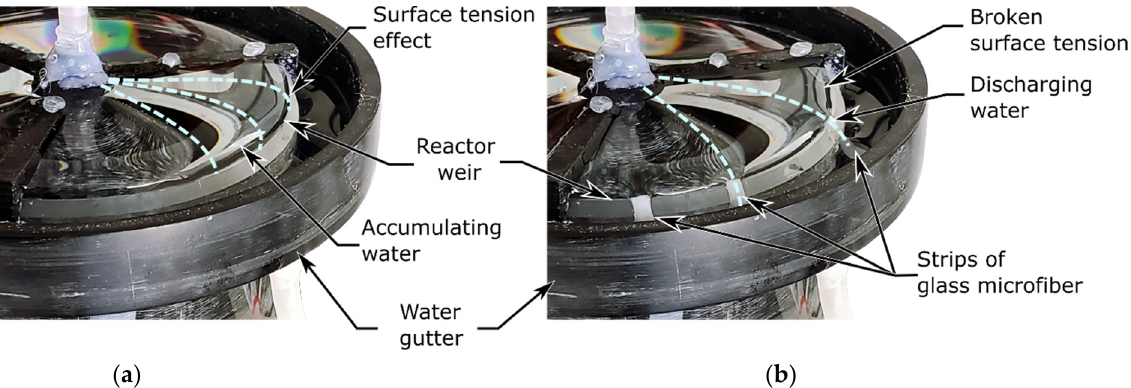
Figure 8. Water surface tension effect on the reactor weir. ( a ) Retained water volume before falling over the reactor weir; ( b ) Continuous water discharge over the reactor weir using glass microfiber strips.